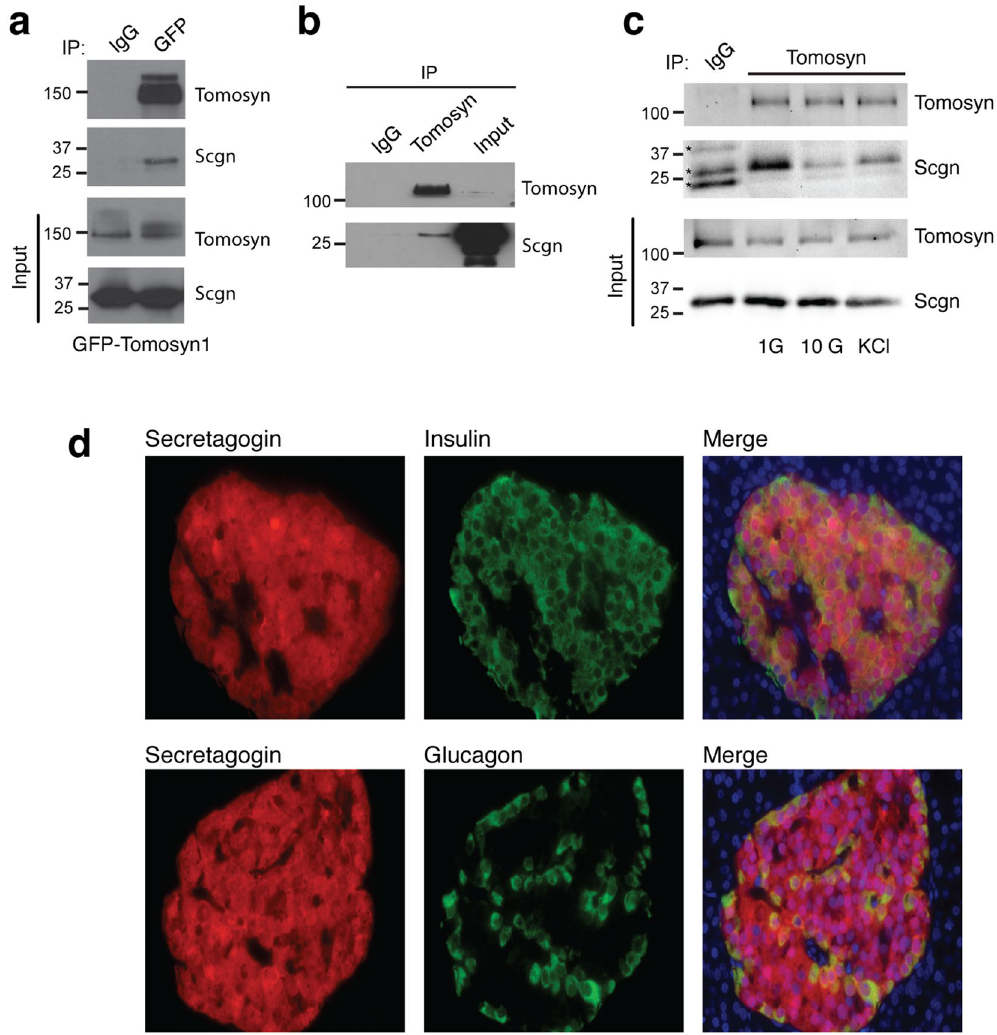
Figure 2. Tomosyn and secretagogin interaction decreases in response to insulin secretagogues. ( a ) Pull-down of GFP-tomosyn1 demonstrates an interaction with secretagogin (Scgn) in INS 832/13 cells (representative of n = 4). ( b) Pull-down of native tomosyn demonstrates an interaction with secretagogin in human islets (representative of n = 3). ( c) Stimulation with 10 mM glucose and 30 mM KCl for 15 minutes reduces the tomosyn and secretagogin interaction (representative of n = 3). ( d) Secretagogin is expressed in ß- and α -cells as shown by immunostaining of human pancreatic sections for secretagogin (red) and insulin (green, top ) or glucagon (green, bottom ) (representative of pancreatic section from 6 human donors). * Unspecific